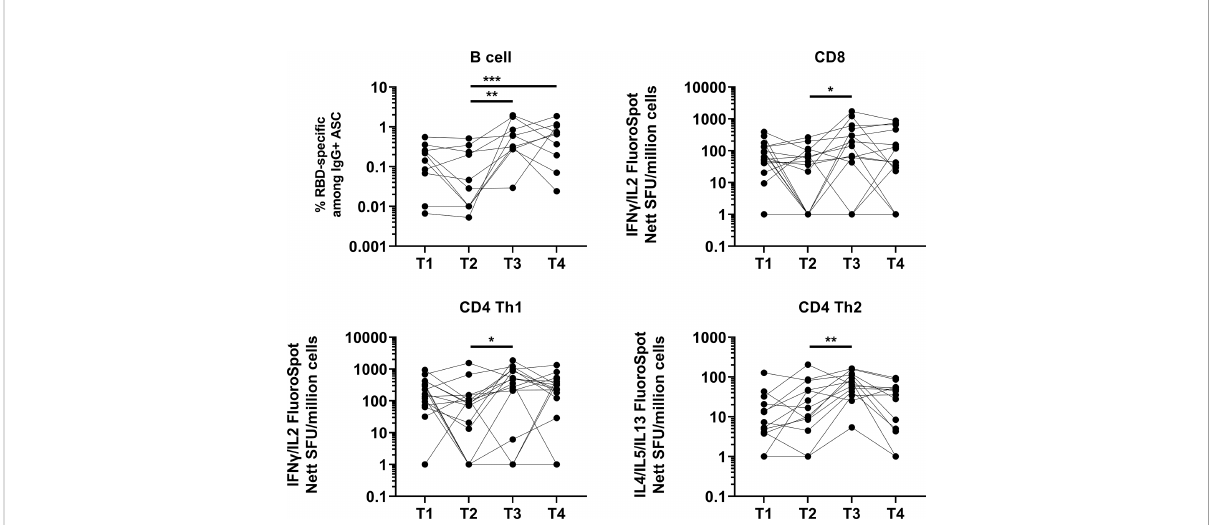
FIGURE 2 Induction and waning of memory B and T cell response against Spike following booster vaccination. RBD-speci fi c memory B (N=10), Spike- protein-speci fi c CD8 (N=16), CD4 Th1 (N=16) or CD4 Th2 (N=13) responses. For memory B cell response, frequency of IgG RBD-speci fi c memory B cells among total IgG antibody secreting cells (ASCs) is presented. For CD8, CD4 Th1, and CD4 Th2 responses, data presented are spot forming units (SFU) per million PBMC from paired samples at four time-points. Each data point represents the normalized mean spot count from duplicate wells, after subtraction of medium-only control. To compare between timepoints, Friedman tests and post hoc tests using Dunn ’ s multiple comparison tests were used. *, P-value <0.05; **. P-value <0.01; ***, P-value